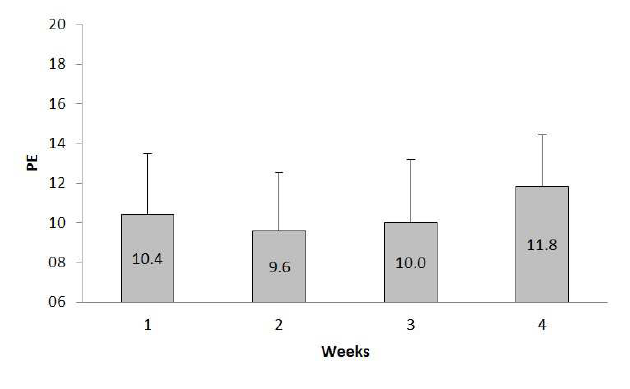
Figure 2. Perceived exertion (PE) values obtained during the last training session of weeks 1-4.